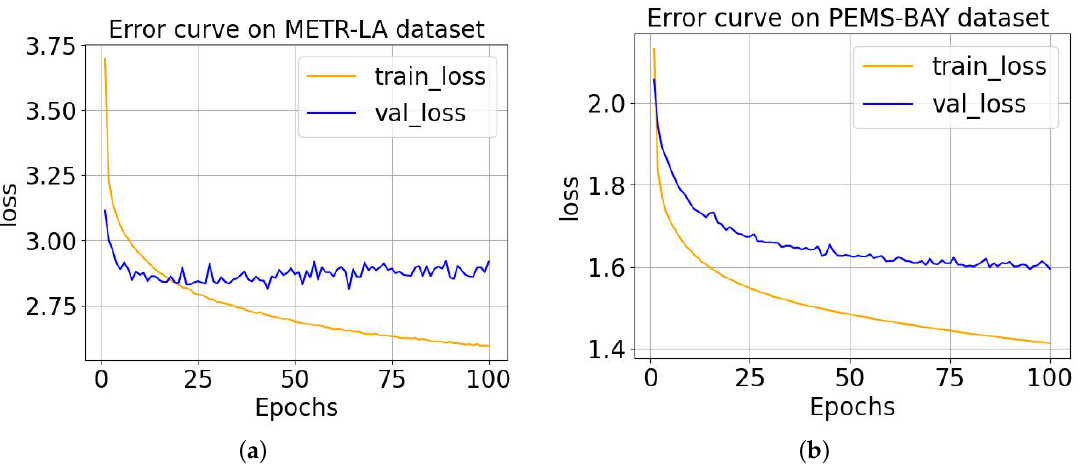
Figure 5. The training and validation error curves of the MD-GCN model on two datasets. ( a ) MD- GCN training and validating errors on the METR-LA dataset; ( b ) MD-GCN training and validating errors on the PEMS-BAY dataset.